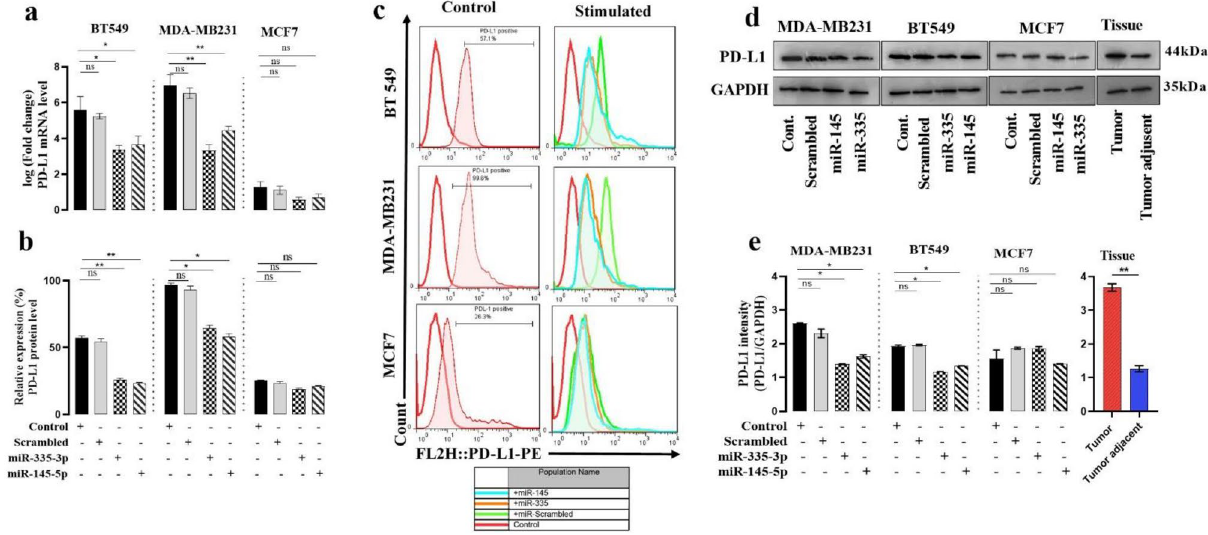
Figure 5. The effect of overexpression of miR-335 and -145 in the control of PD-L1 expression in mRNA and protein levels. ( a ) PD-L1 expression levels through miR ‐ 335 and -145 transfection were analyzed using qRT ‐ PCR. The results showed that miR ‐ 335 and -145 exogenous overexpression could significantly reduce PD-L1 expression at the mRNA level in BC cell lines. ( b ) Graphs represent PD ‐ L1 protein expression levels. ( c ) FACS analysis of PD-L1 in breast cancer cell lines. Anti-human PD-L1 was used as a binding antibody to cell-surface PD-L1 protein. ( d ) Western blots showing changes in expression levels of PD-L1 protein after miRNA transfection in breast cancer cell lines and tissue. ( e ) Statistical histogram of the western blots (n = 3). GAPDH was used as a loading control. All data were presented as mean ± SEM. *P ≤ 0.05, **P ≤ 0.01, ***P ≤